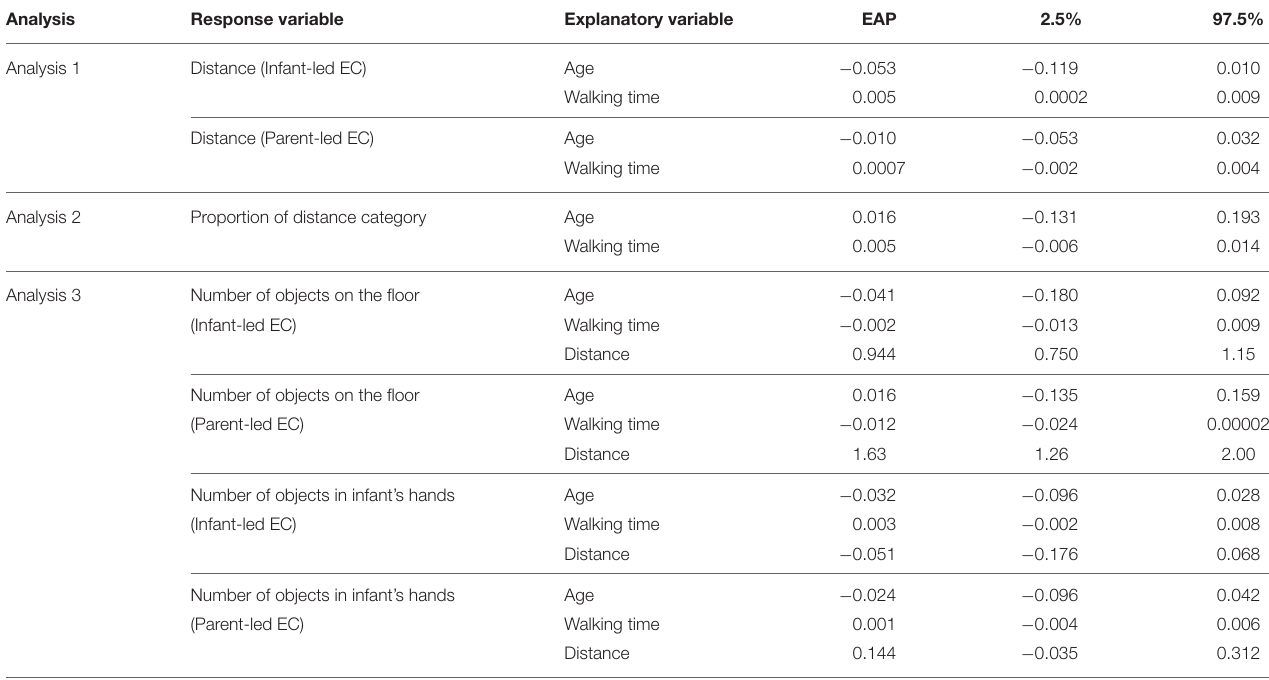
TABLE 1 | The posterior distribution of the parameters of the